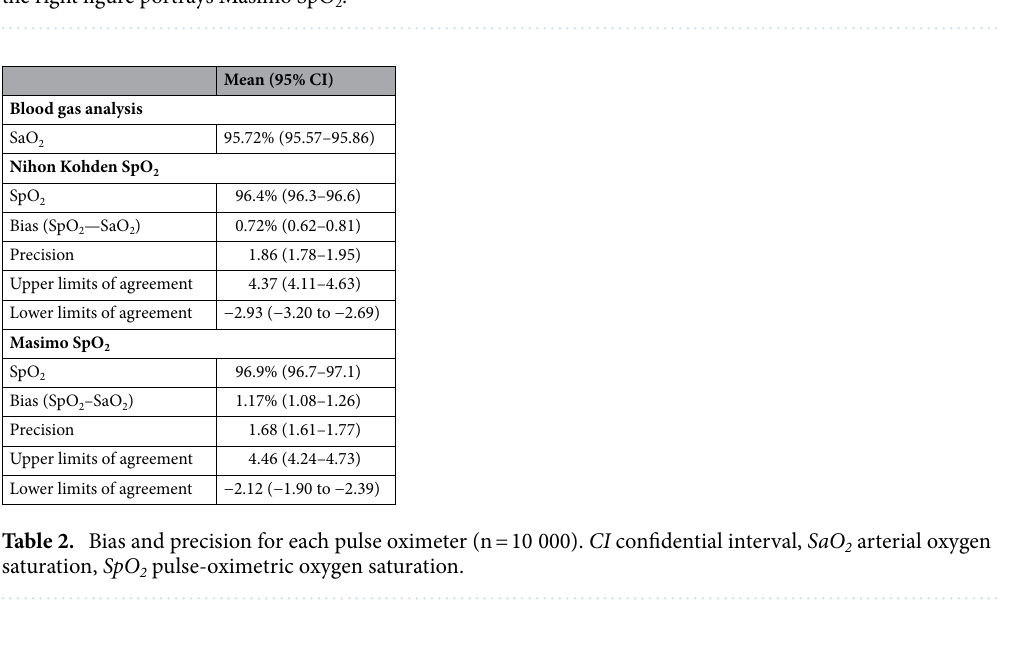
Figure 2. Bland–Altman plot comparing SaO 2 and SpO 2 . The horizontal axis represents (SpO 2 + SaO 2 )/2. The vertical axis represents SpO 2 – SaO 2 . The middle horizontal red line represents bias. The upper horizontal red dotted line represents the upper limits of agreement, and the lower horizontal red dotted line represents the lower limits of agreement. Black dots represent each test result. The left figure portrays Nihon Kohden SpO 2 , and the right figure portrays Masimo SpO 2 .